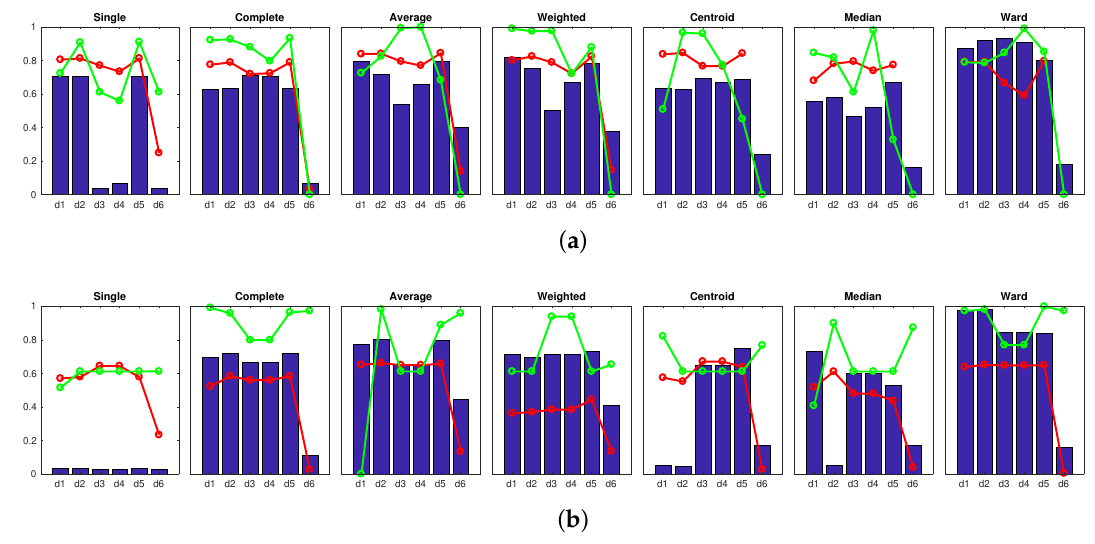
Figure 20. Legend: (cid:4) Accuracy c ; −◦− Correlation γ coph ; −◦− Inconsistency δ inconsist . Results of the high-level clustering with the complete dataset. CNN descriptor ( a ) layer fc7 (4096 components) and ( b ) layer fc8 (205